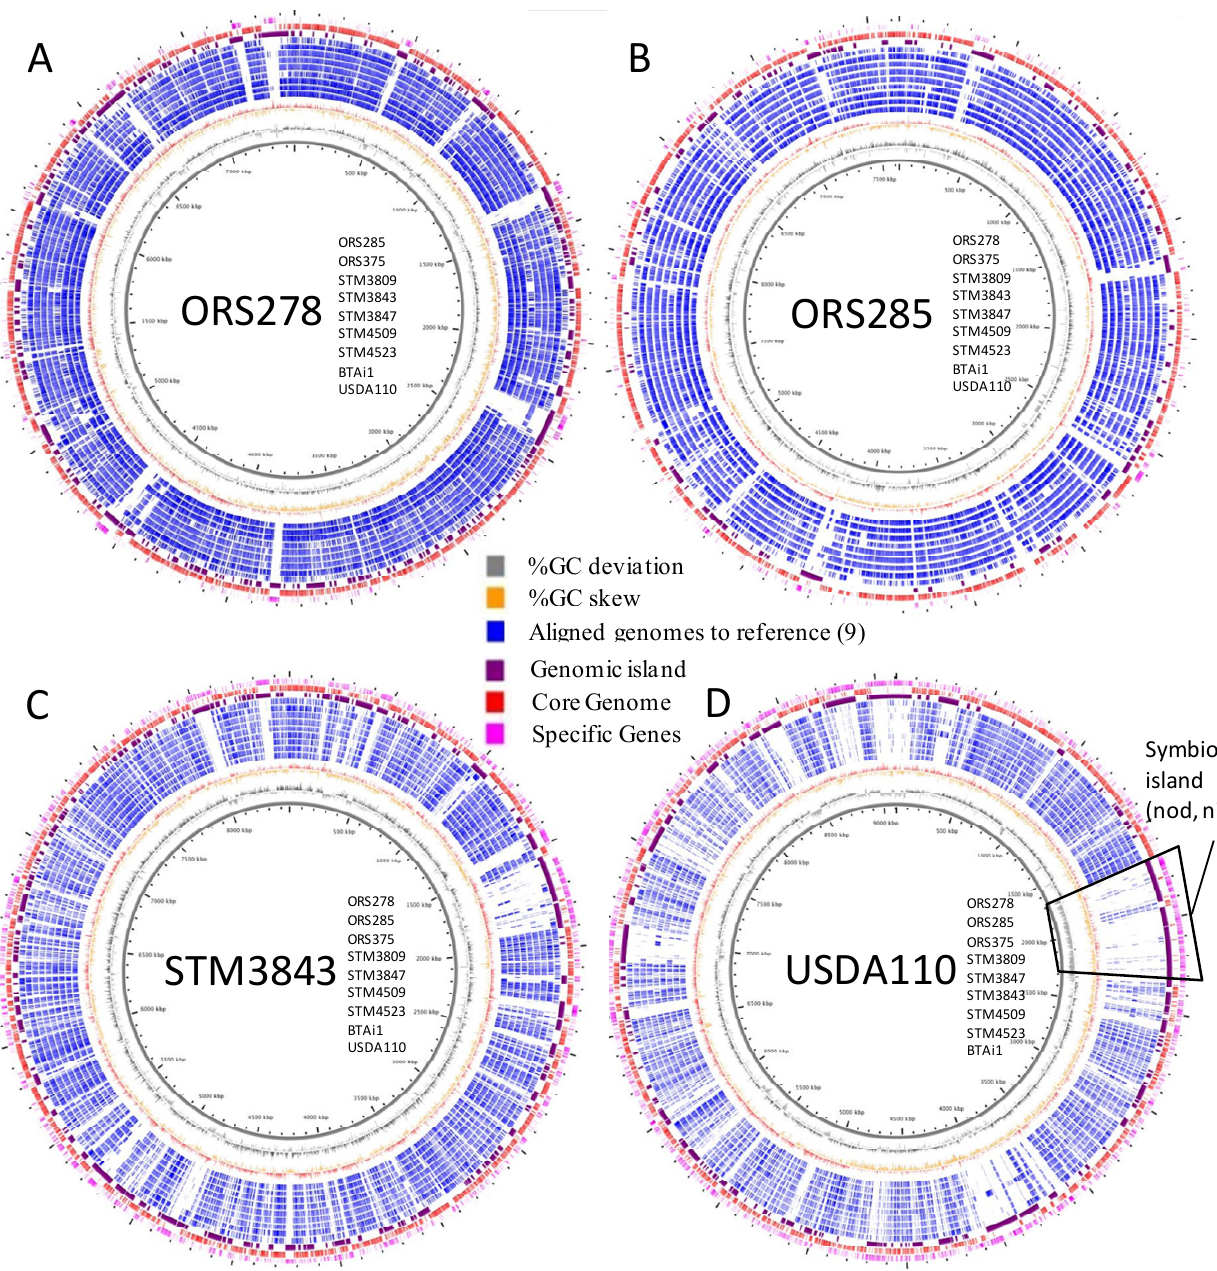
Figure 3. Circular view of whole genome alignments of bradyrhizobial genomes. Genomes were aligned to a reference genome [for ( A ) ORS278, ( B ) ORS285, ( C ) STM3843, ( D ) USDA110)]. The localization of aligned genomes is given as a list from inner to outter circles in the center of each figure. Legend (from inner to outter layer of circles: genome scale (kb), GC deviation (gray), GC skew (orange), aligned genomes (aligned parts are in blue, each layer is a different genome, strains are listed close to the reference genome name in the center of each figure, from inner to outer layers), GI (purple), core genome (red), specific genes to reference genomes (pink). Higher resolution images for each genome analysis are available in Supplementary Figure